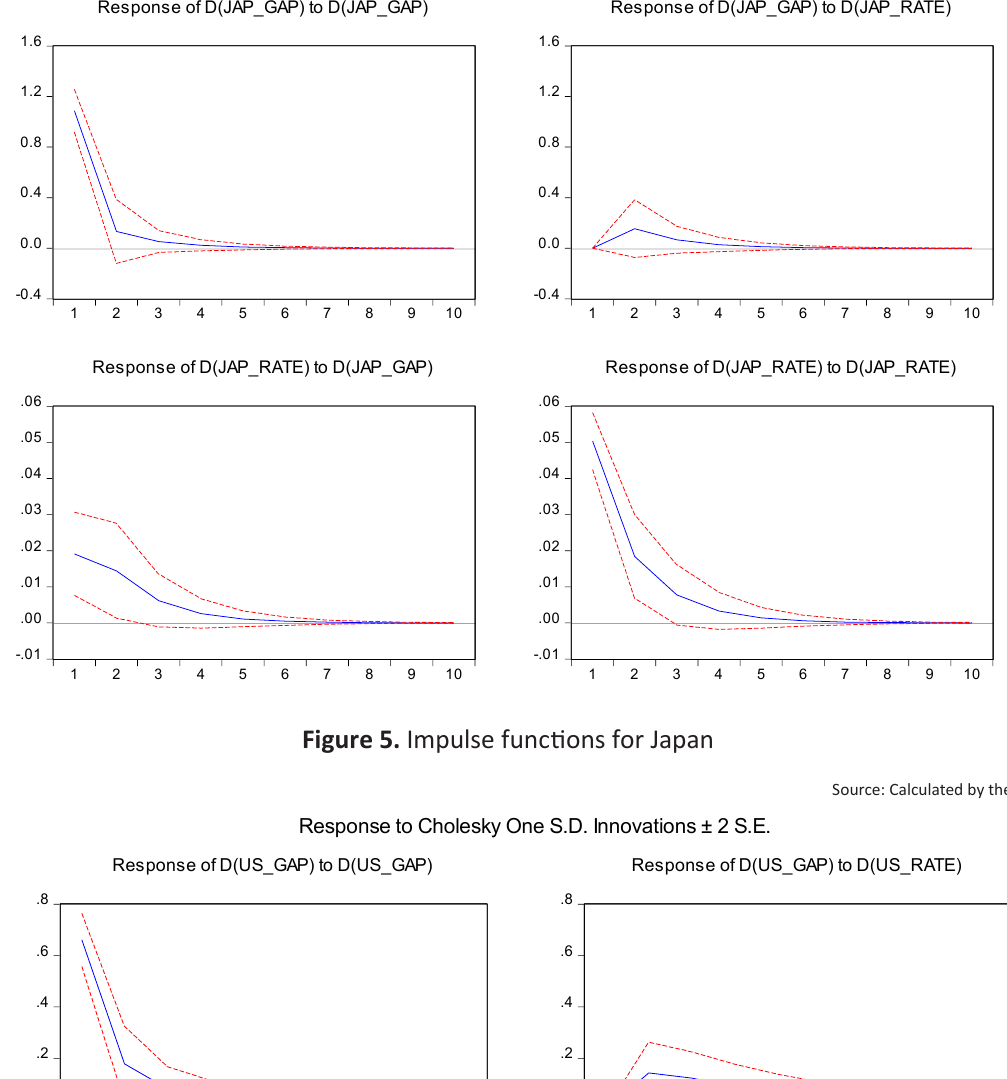
Figure 5. Impulse functions for Japan